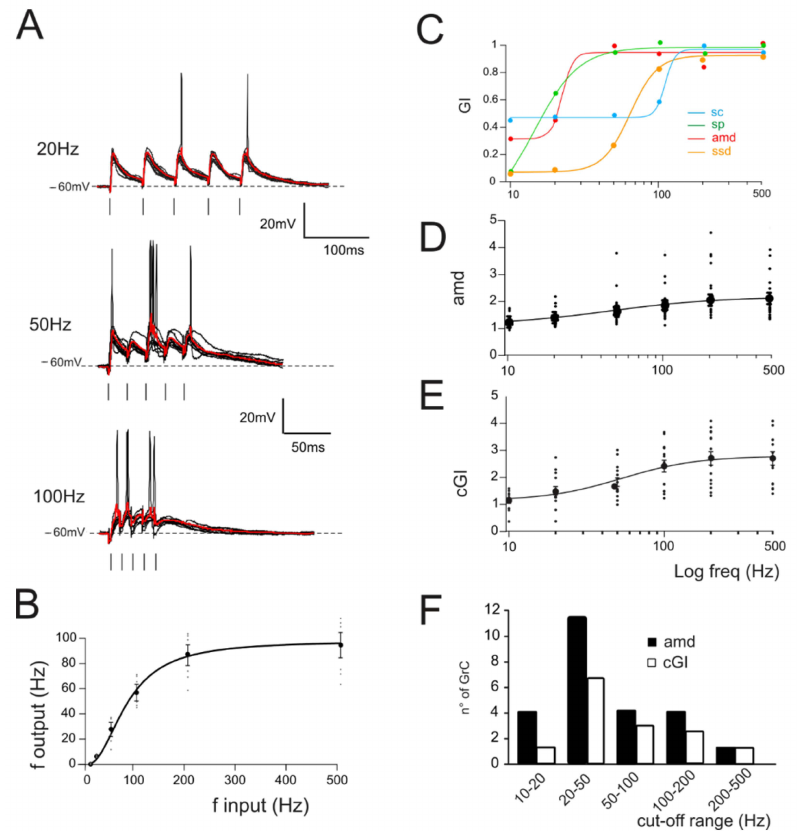
Figure 2. Gain curves in GrCs. ( A ) Voltage traces recorded from a single GrC stimulated with